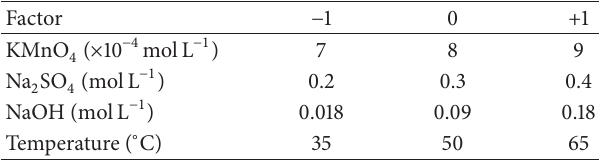
Table 1: Coded values for the factorial